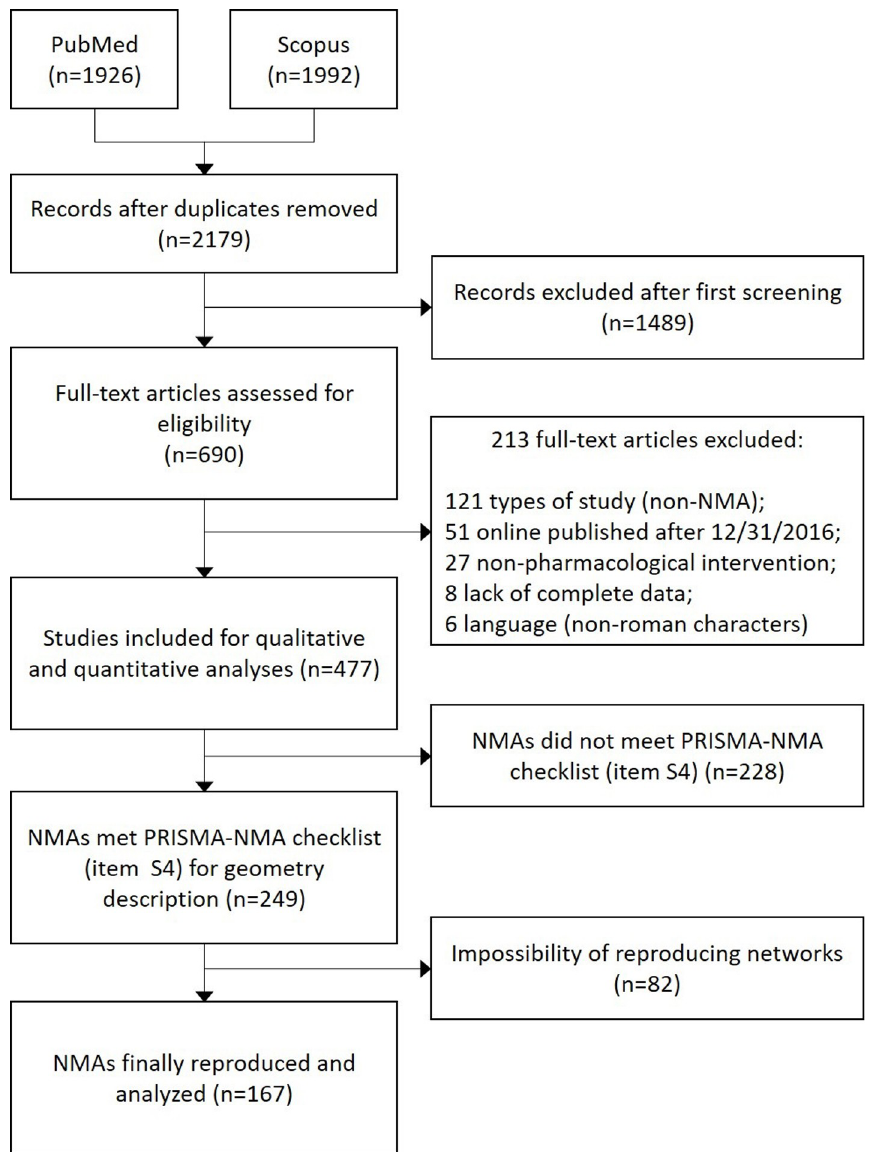
Fig 1. Flowchart of the included NMAs for network-plot reproduction and geometry